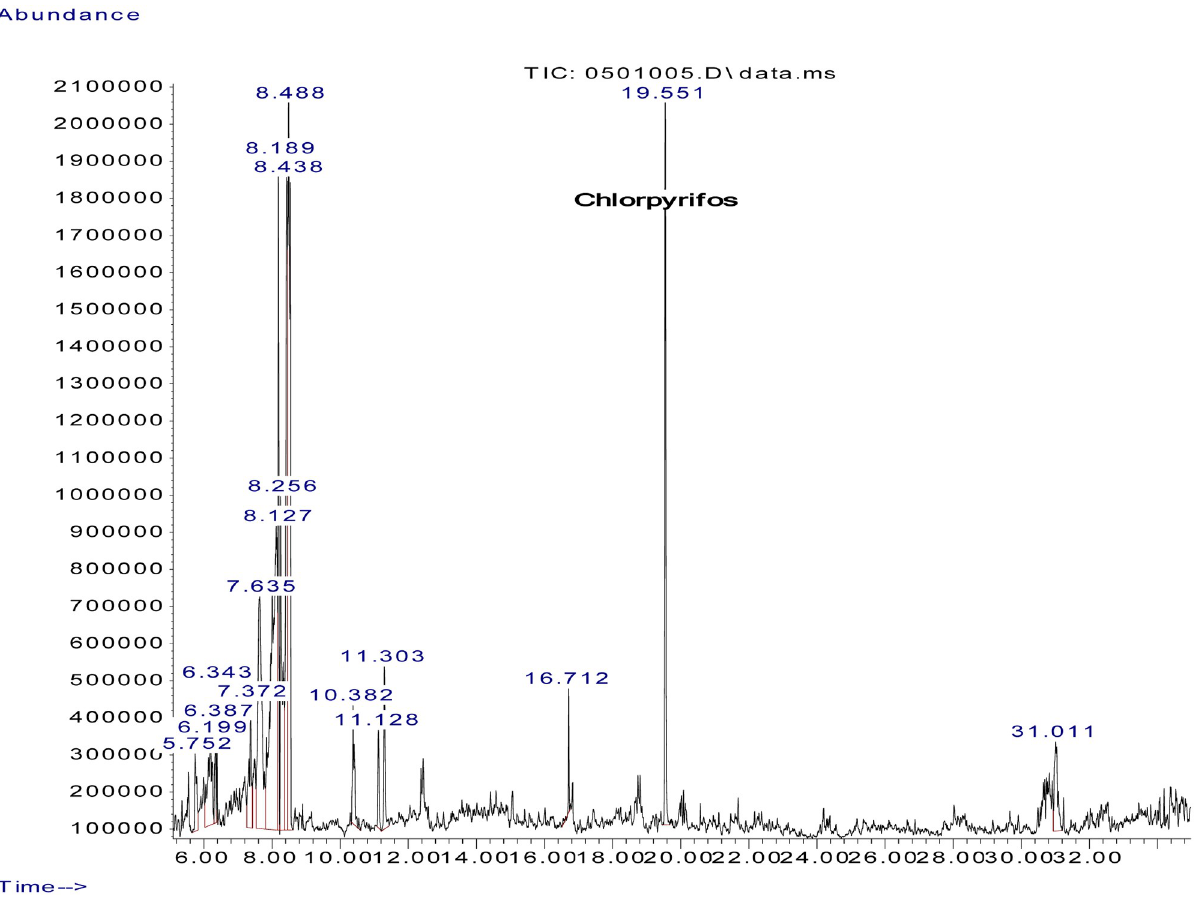
Fig 1. Chromatogram of chloropyrifos in Chinese cabbage.